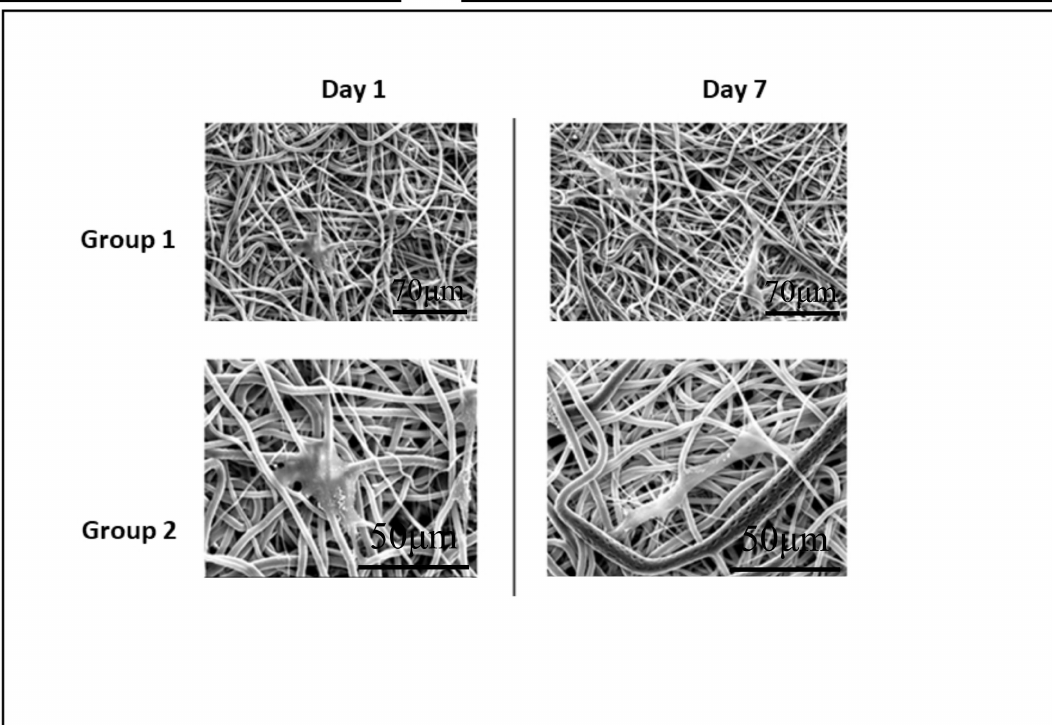
and Group 2 – Nanotubes of TiO 2